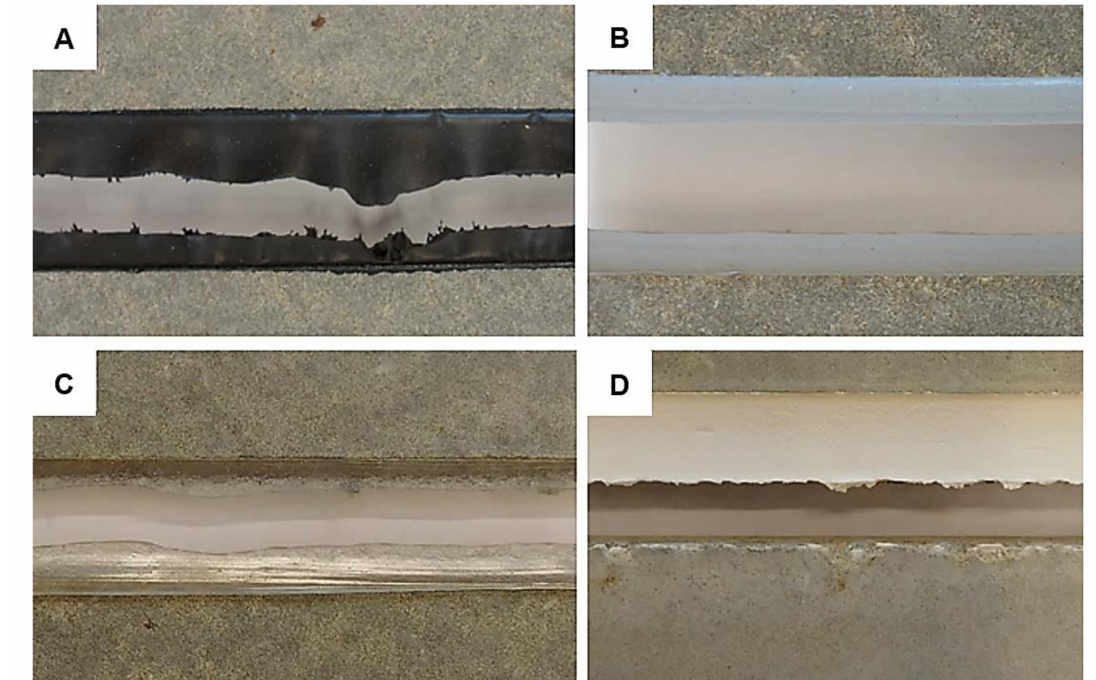
Figure 10. Examples of typical failure modes monitored with design A: ( A ) cohesive failure (CF) of PU / 2 after more than 400% extension; ( B ) CF of PU / 2 / 2 after extension to approximately 50%; ( C ) CF of MS / 1 / 3 after c. 80% relative elongation; ( D ) adhesive failure (AF) of MS / 1 /